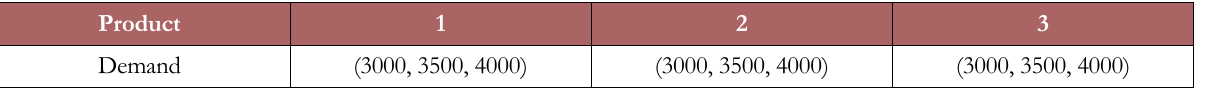
Table 1. The aggregate demand ( )